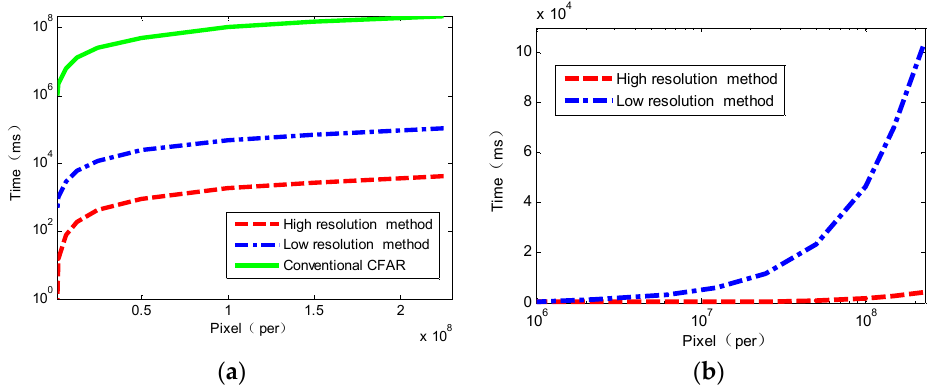
Figure 13. Comparison of time consumption between the proposed method and conventional CFAR ( a ), the high and low resolution method ( b ).